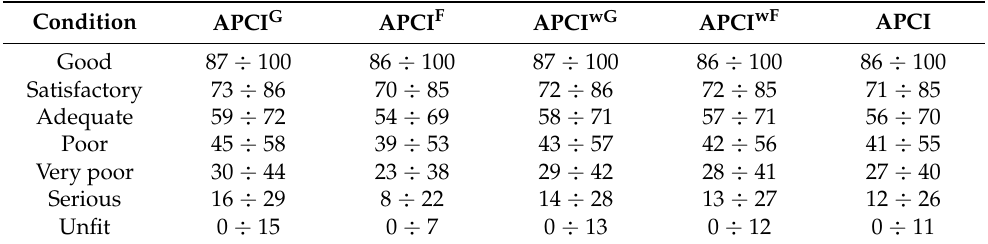
Figure 4. Criteria for assessing the technical condition of the pavement of the airport functional element using the APCI method. Table 3. Criteria for assessing the technical condition of airfield’s functional element pavements based on the